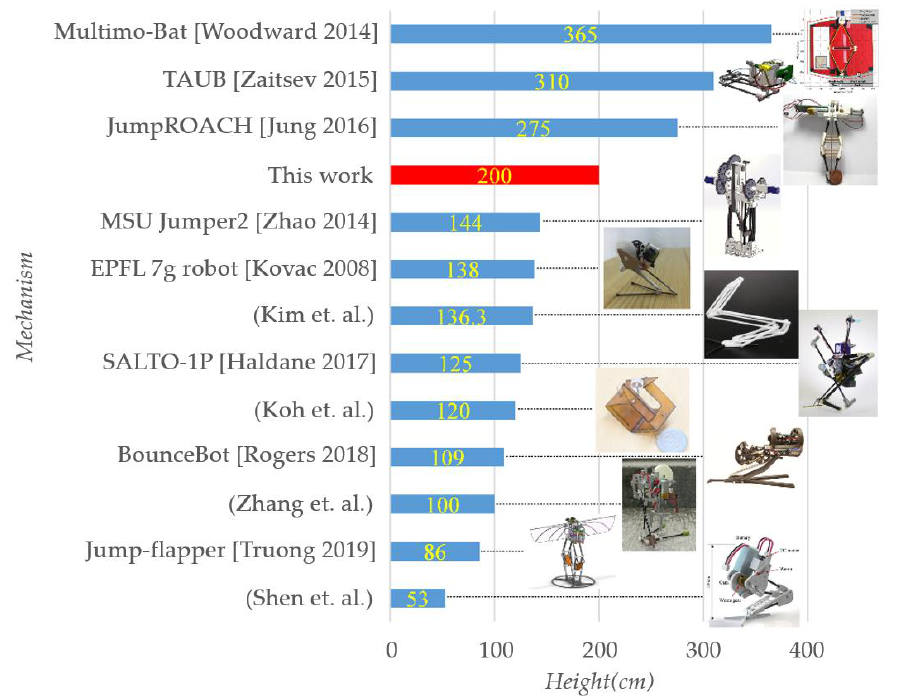
Figure 14. Listing of jumping-height performance for well-known miniature jumping mechanisms proposed